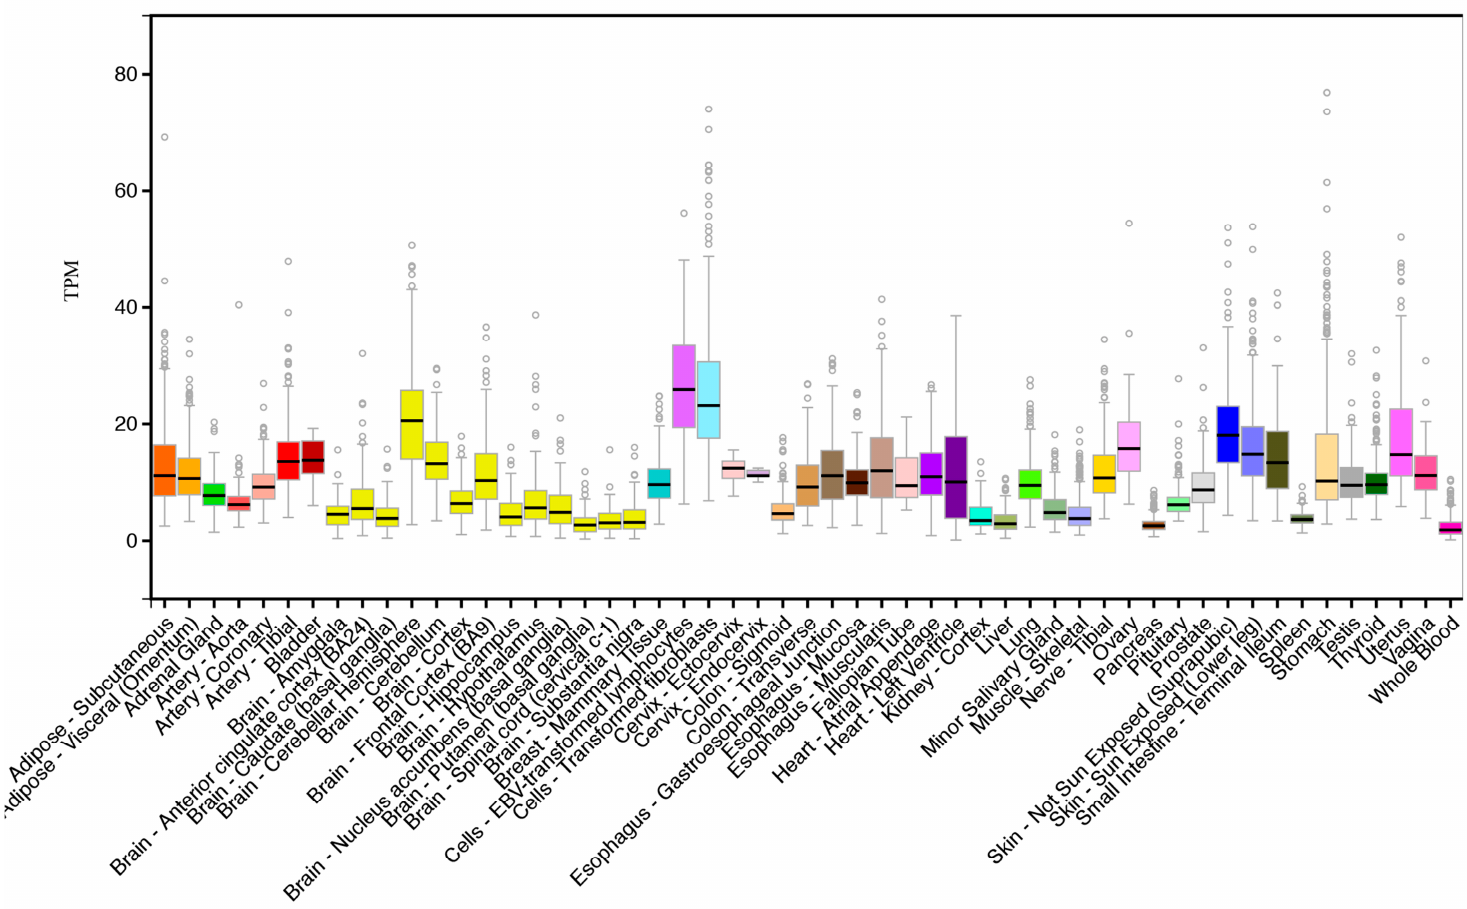
Figure 4. Comparative tissue expression levels for human CERS6. RNA-seq gene expression profiles across 53 selected tissues (or tissue segments) were obtained from the public database for human CERS6 , based on expression levels for 175 individuals (Data Source: GTEx Portal, GTEx Analysis Release V6p (dbGaP, accession number phs000424.v6.p1; https://gtexportal.org/home/gene/ENSG00000172292.10). TPM, Transcripts per million, calculated from a gene model with isoforms collapsed to a single gene. Box plots show a median and 25th and 75th percentiles; points are shown as the outliers if they are above or below 1.5 times the interquartile range.